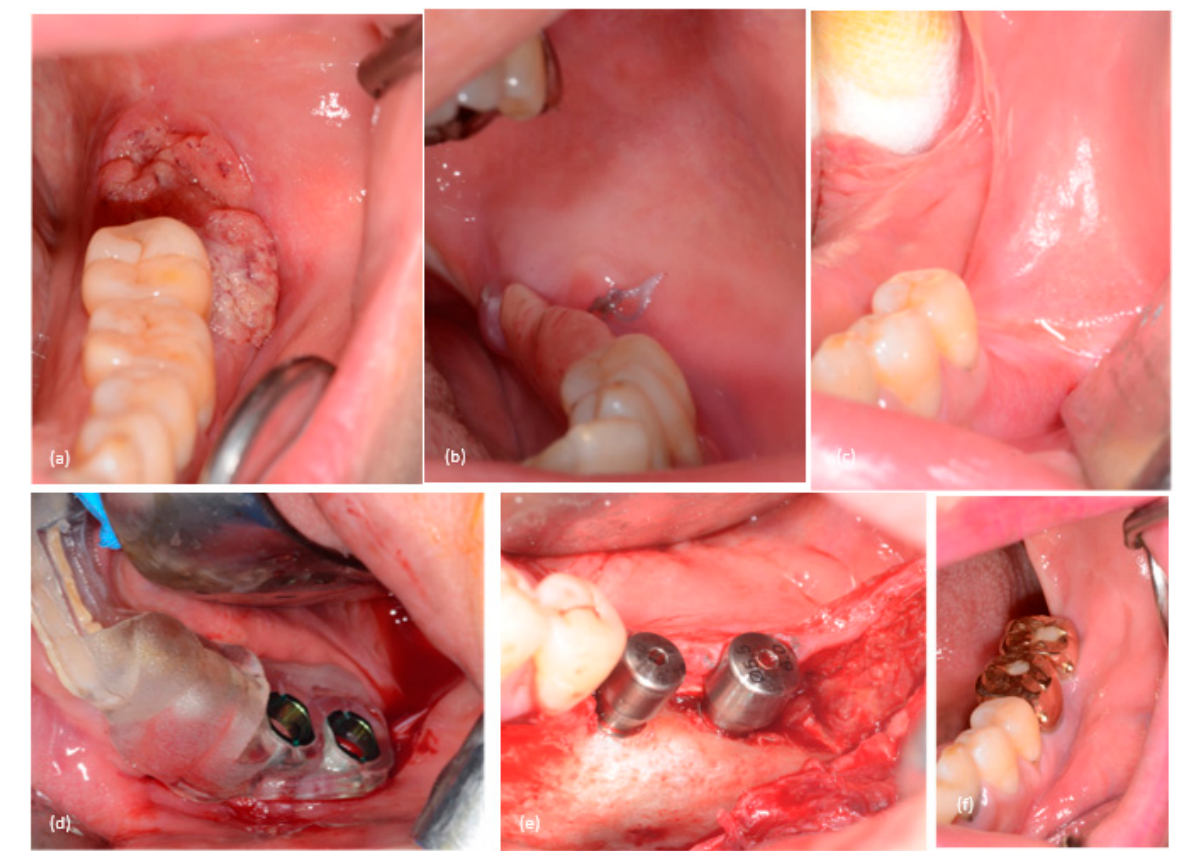
Figure 1. Clinical photos of case, A 59-year-old woman was diagnosed with squamous cell carcinoma on left mandible (#36–38), and segmental mandibulectomy was performed, and two implants were installed by computer-guided implant surgery. ( a ) Pre-operative intra-oral photo. ( b ) Post operative intra-oral photo after 1 month. ( c ) Mucosal healing was competed at 1 years’ intra-oral photo. ( d ) Computer-based implant guided was applied for implant placement. ( e ) Connect the healing abutment and vestibuloplasty was performed. ( f ) Screw-type implant prosthesis was delivered.